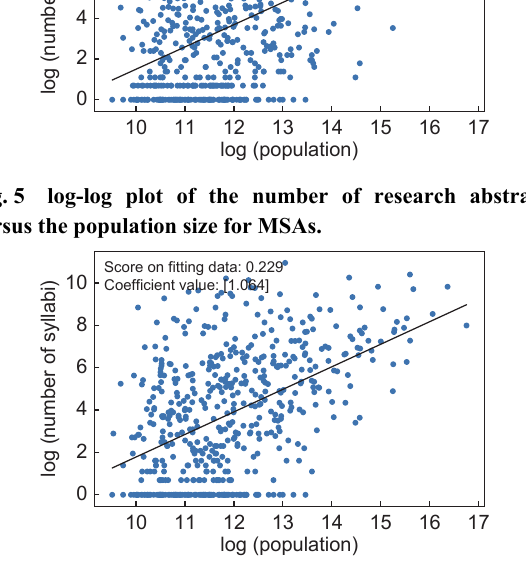
Fig. 6 log-log plot of the number of teaching syllabi versus the population size for